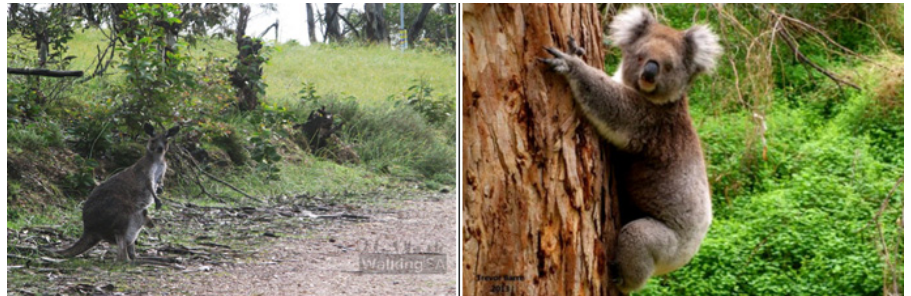
Figure 9. Chambers Gully Park, Adelaide, Australia [39].